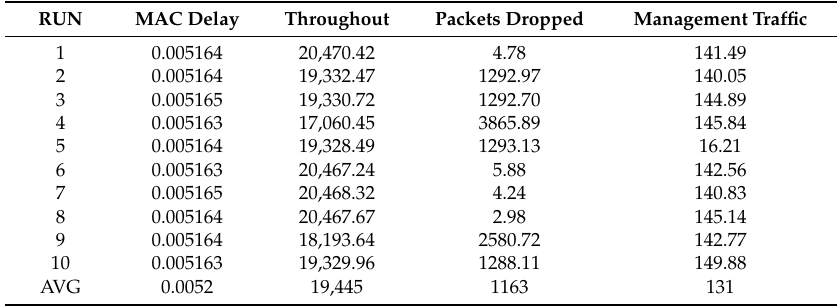
Table 14. Patient Bed Scenario ACO.